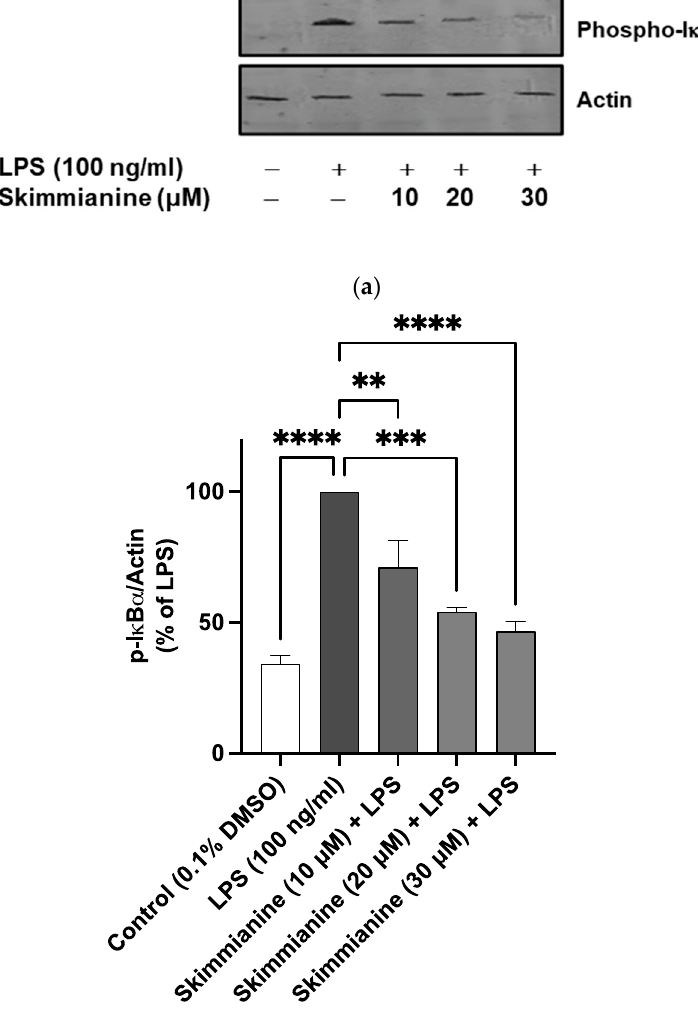
Figure 7. Skimmianine interferes with I κ B phosphorylation. BV-2 microglia were pre-treated with skimmianine (10, 20 and 30 μ M) for 30 min before they were stimulated with LPS (100 ng/mL). Cell lysates were subjected to a western blot analysis for phospho-I κ B α ( a ). Densitometric analyses of the membranes were performed with Image J software ( b ). Values are mean ± SEM of at least three independent experiments. A statistical analysis was carried out using a one-way ANOVA with a post hoc Dunnett’s test. ** p < 0.01; *** p < 0.001; **** p < 0.0001 in comparison with LPS stimulation.